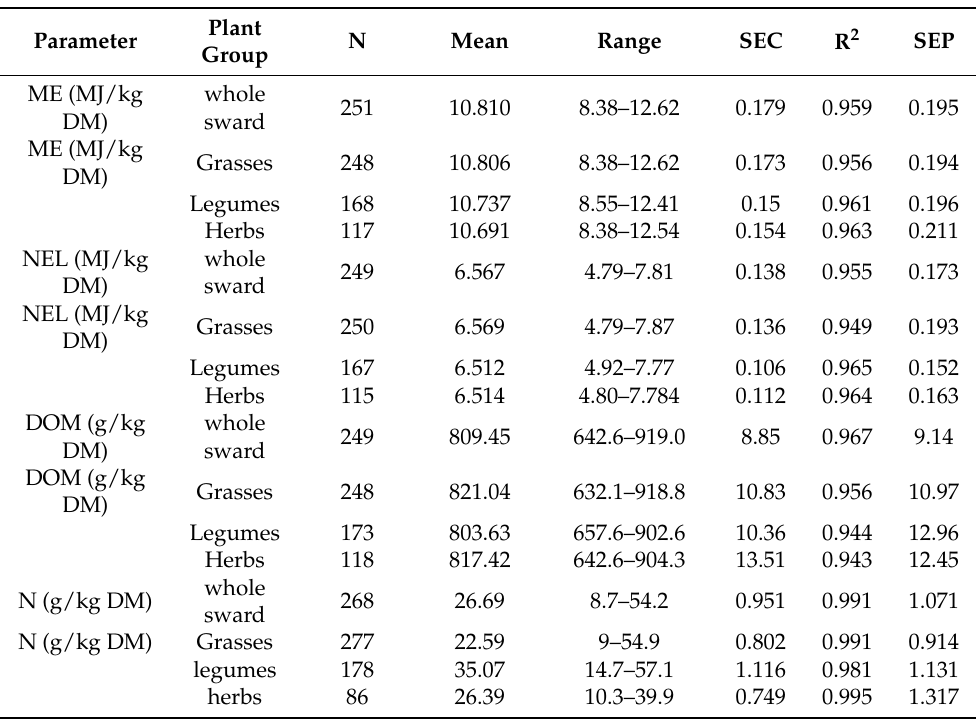
Table A1. Statistical data of the NIRS calibration and validation (SEC, standard error of calibration; SEV, standard error of prediction) for the relevant quality parameters by plant